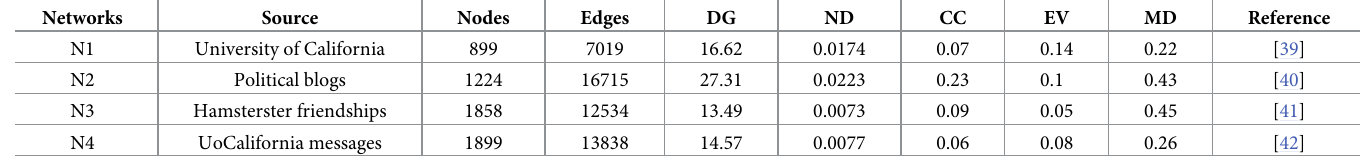
Table 1. Main network characteristics for Networks N1–N4, including the number of nodes and edges, the mean degree (DG), network density (ND), global cluster- ing coefficient (CC), mean eigenvector centrality (EV), and modularity (MD). Networks